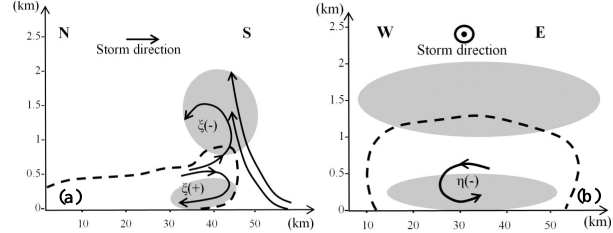
Fig. 10. Schematic representation of the flow structure during the cool pool intrusion. The dashed line indicates the boundary of the density current. Shaded figures indicate areas of increased turbu- lence. (a) Considering a NS vertical plane parallel to the axis of motion, the flow is rotating clockwise close to the surface ( ξ + ) and anti-clockwise above ( ξ − ). (b) Considering a WE vertical plane perpendicular to the motion the flow is rotating anti-clockwise ( η − ). The storm direction in this figure is towards the reader.